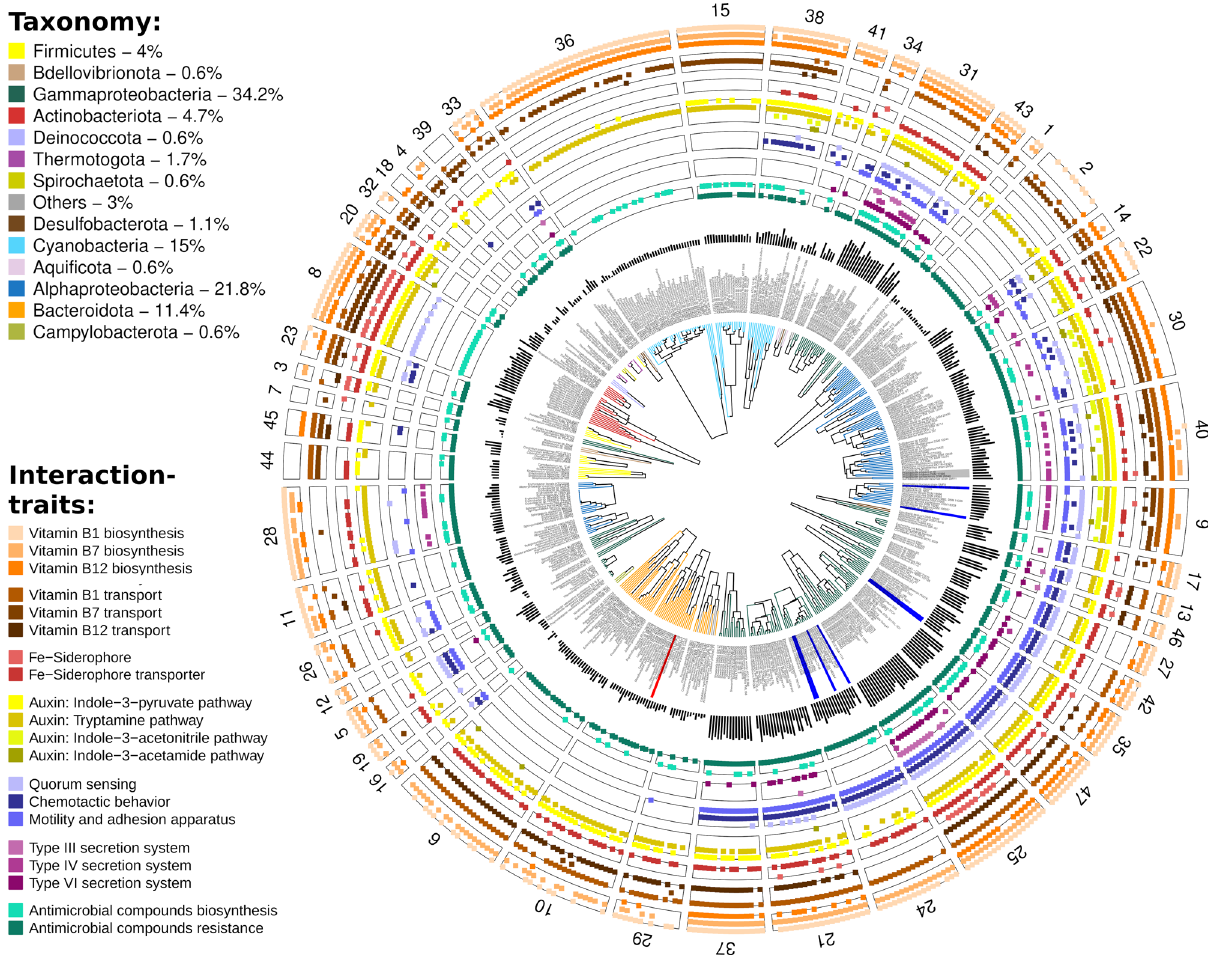
Fig. 2 Distribution of interaction traits known to mediate cell – cell interactions in bacterial model systems. Each slice shows the interaction traits present in a genome functional cluster (GFC) and, as a dendrogram, the functional similarity of genetic traits between the grouped genomes (hierarchical clustering of the r -correlation matrix with complete agglomeration algorithm). The dark bars show the number of interaction traits annotated in each genome. Genomes belonging to model bacteria, used in literature to discover some of these traits, are highlighted in blue if the interaction was positive (e.g. enhancing phytoplankton growth), in red if it was negative (e.g. kill the host) or in grey if the interaction shifted from positive to